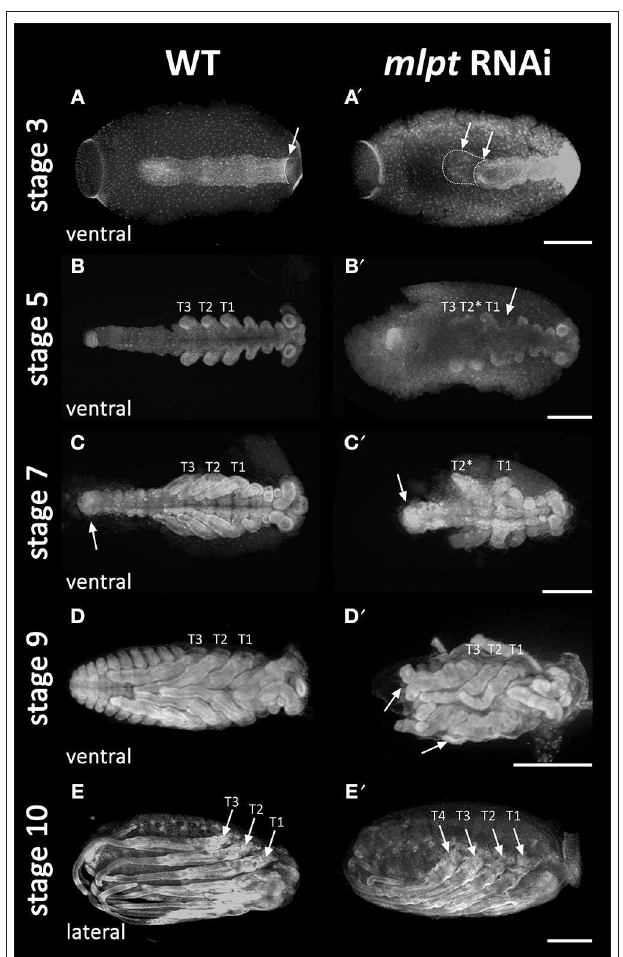
FIGURE 4 | mlpt knockdown segmentation defects. DAPI staining of control and mlpt RNAi embryos. Anterior region of the egg toward to the left in all panels. (A,A ′ ) Stage 3A. Germ band elongation appears irregular in the RNAi embryo when compared to the controls. (B,B ′ ) Stage 5. Irregular thoracic and gnathal segmentation in the RNAi embryo. (C,C ′ ) Stage 7. Thoracic segmental fusion and improper abdominal in the RNAi embryo segmentation when compared to the control. (D,D ′ ) Stage 9. Third thoracic segment fused lack of abdominal segmentation and dorsal closure when compared to the control (E,E ′ ) Stage 10. Late mlpt RNAi embryo showing four pairs of legs when compared to the three pairs of legs of the control. R. prolixus embryonic staging system was described in Berni et al.